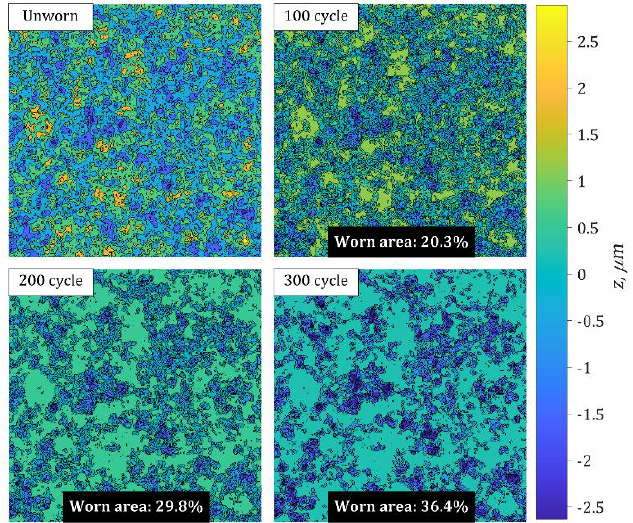
Figure 7. Surface contour as the wear cycle progresses in the truncation